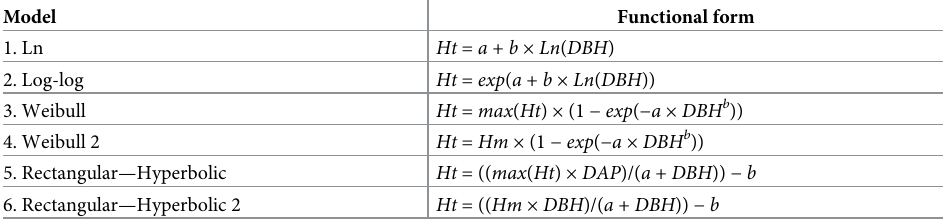
Table 1. Hypsometric models used to describe the relationship between total height and diameter of the trees. Model